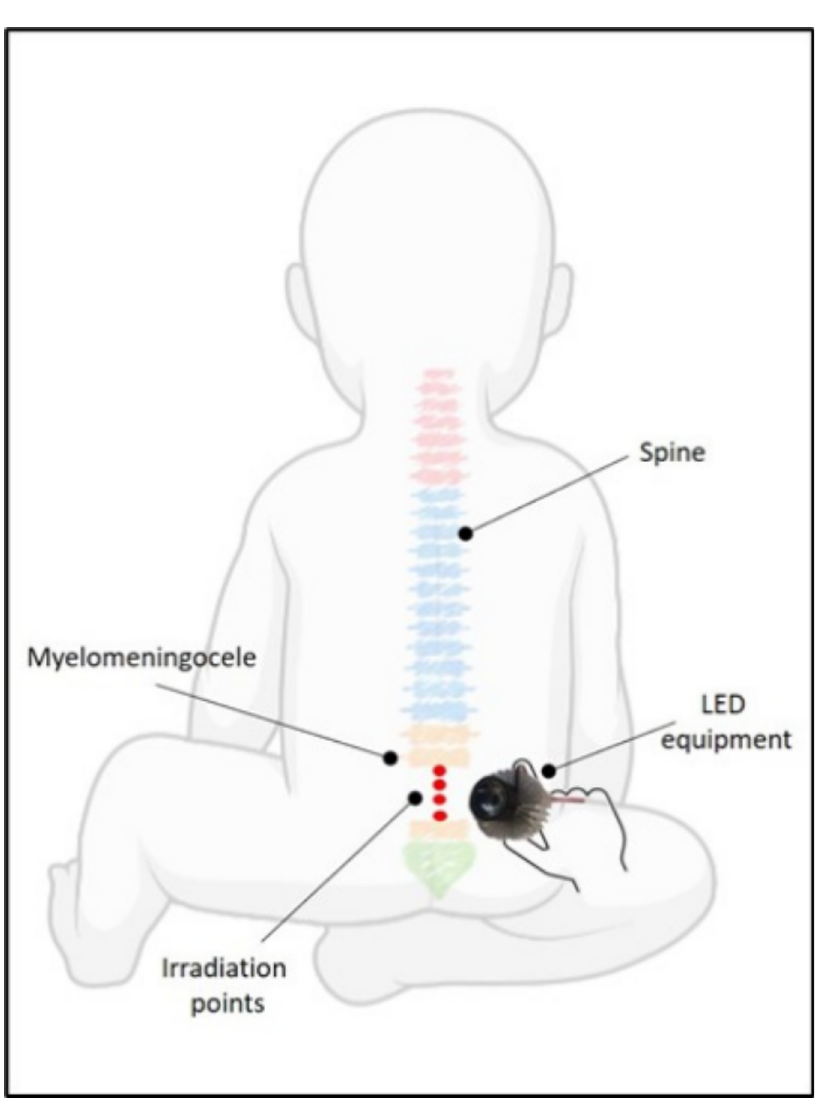
Fig 1. Participant positioning for